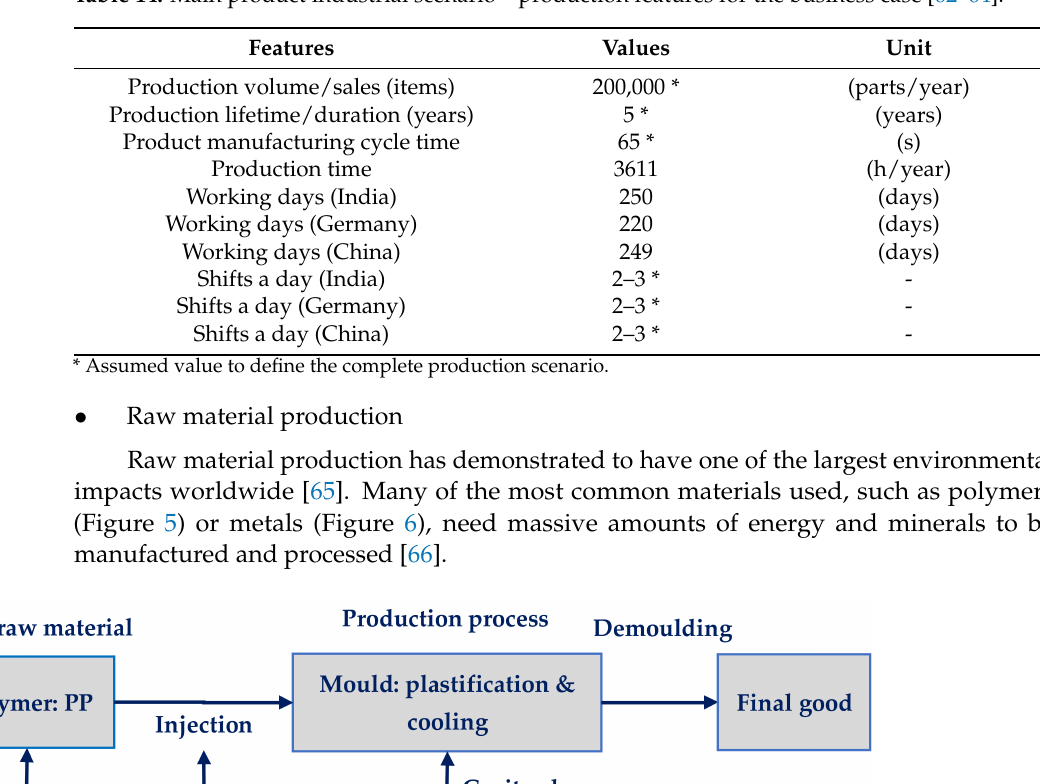
(Table 23), the production line automation level (Table 24) and the equipment efficiency (Table 25).